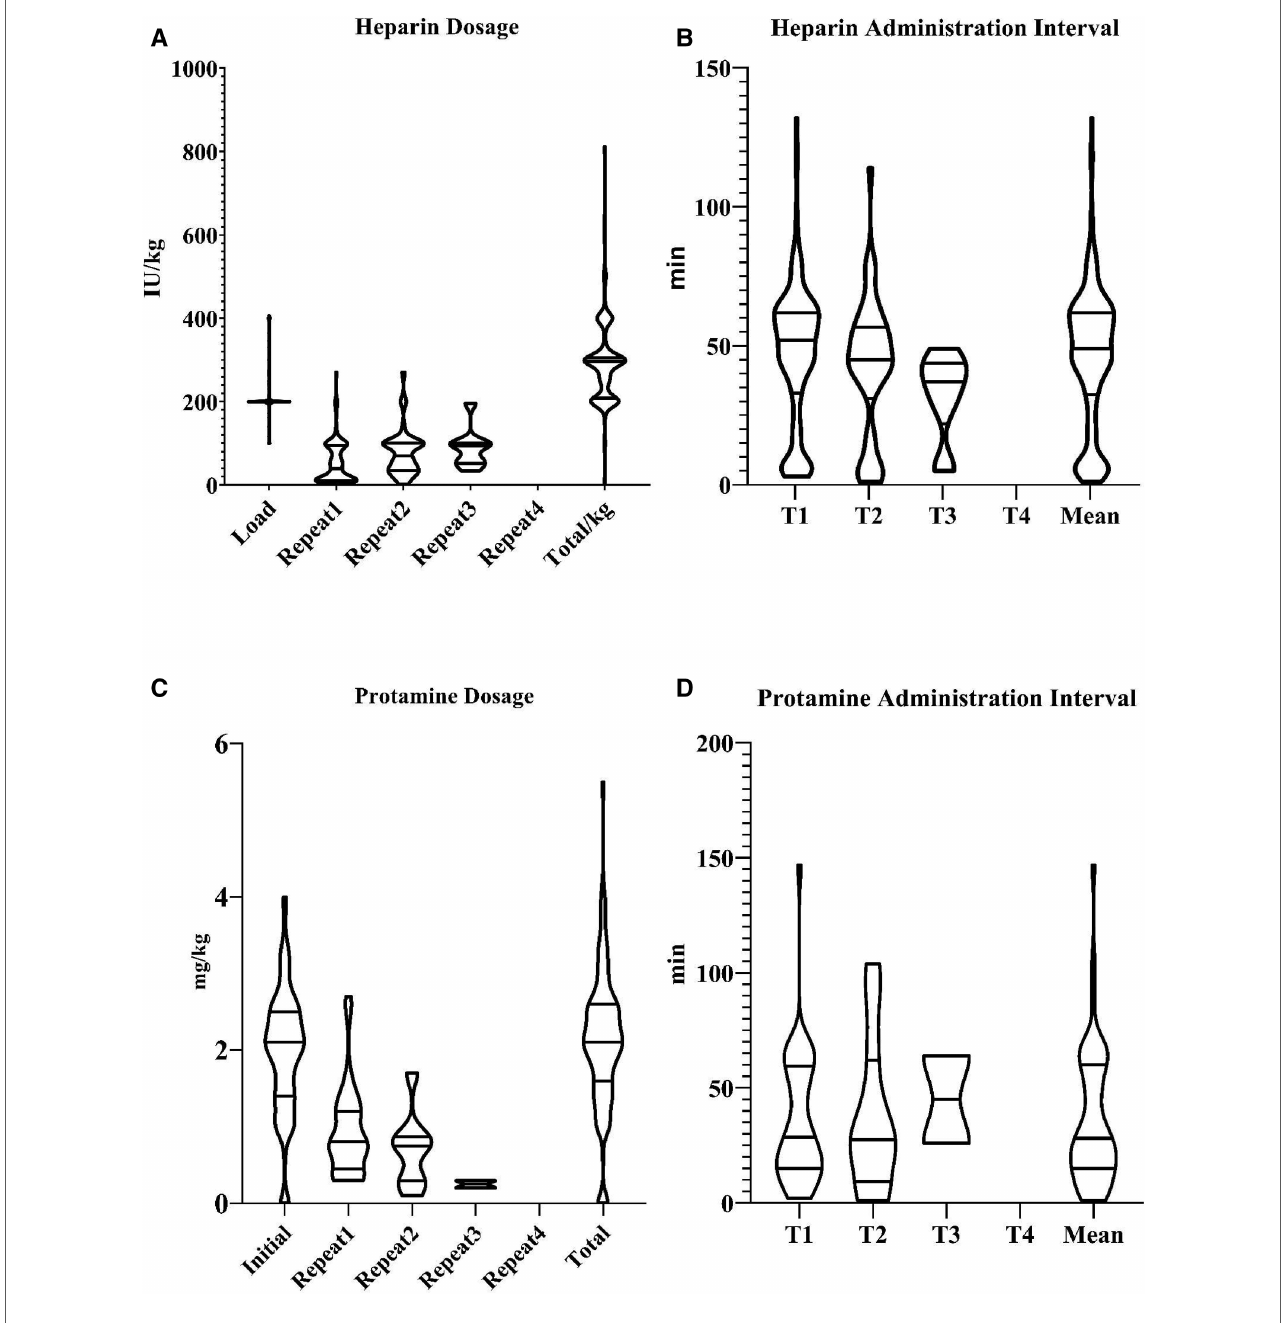
FIGURE 8 Heparinization and reversal strategy. Violin plot was applied to display the intraoperative anticoagulation and reversal strategy. The width of the “ violin ” indicated the distribution and the probability density of the data. The lines inside the “ violin ” indicated the median and the interquartile range. T1: Interval between the loading injection and the fi rst repeated injection; T2: Interval between the second and third repeated injection; T3 and T4 followed the similar